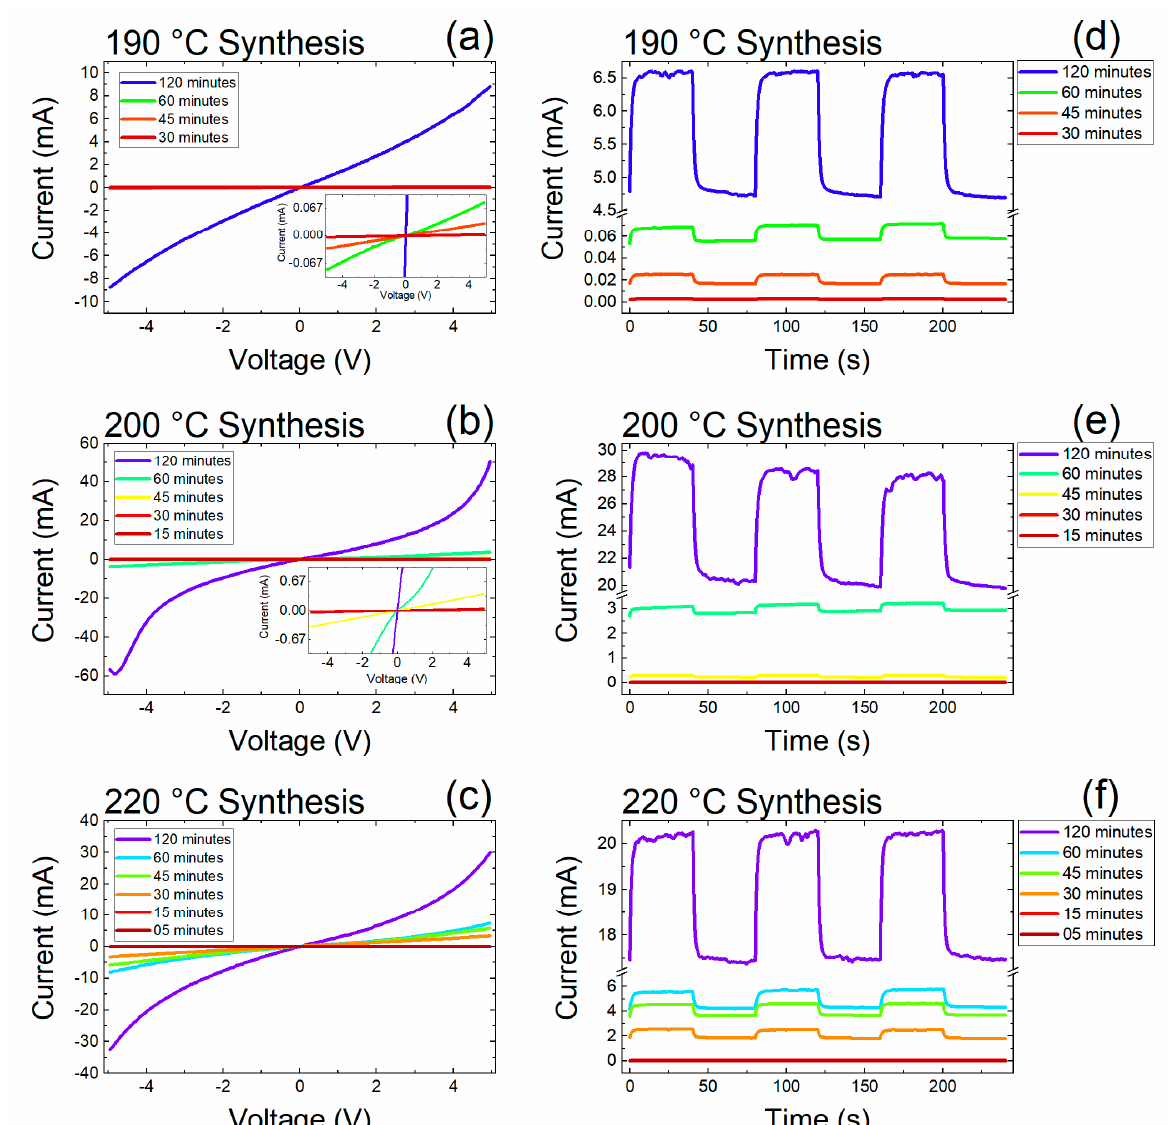
Figure 5. Characterization of infrared photosensors produced with MoS 2 samples grown directly on paper substrates at different times, being: ( a ) IxV of samples synthesized at 190 °C, ( b ) IxV of samples synthesized at 200 °C, ( c ) IxV of samples synthesized at 220 °C, ( d ) Ixt of samples synthesized at 190 °C, ( e ) Ixt of samples synthesized at 200 °C, and ( f ) Ixt of samples synthesized at 220 °C. The Ixt measurements were performed with a bias voltage of 4 V, lighting cycles lasting 40 s and power of 20 mW.